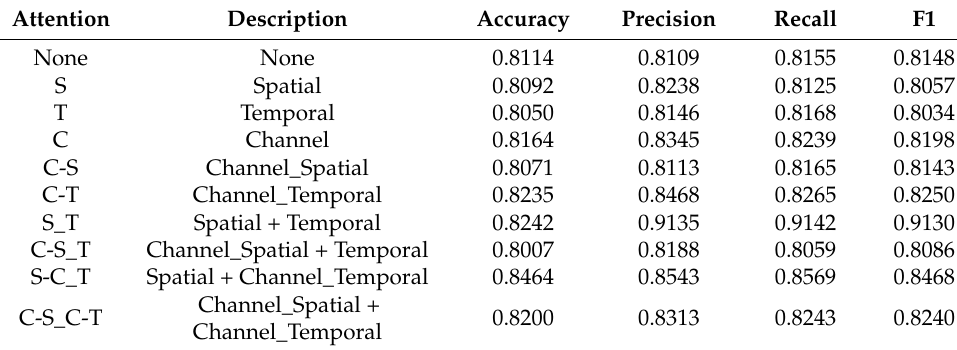
Table 6. Classification performance of different attention mechanisms.